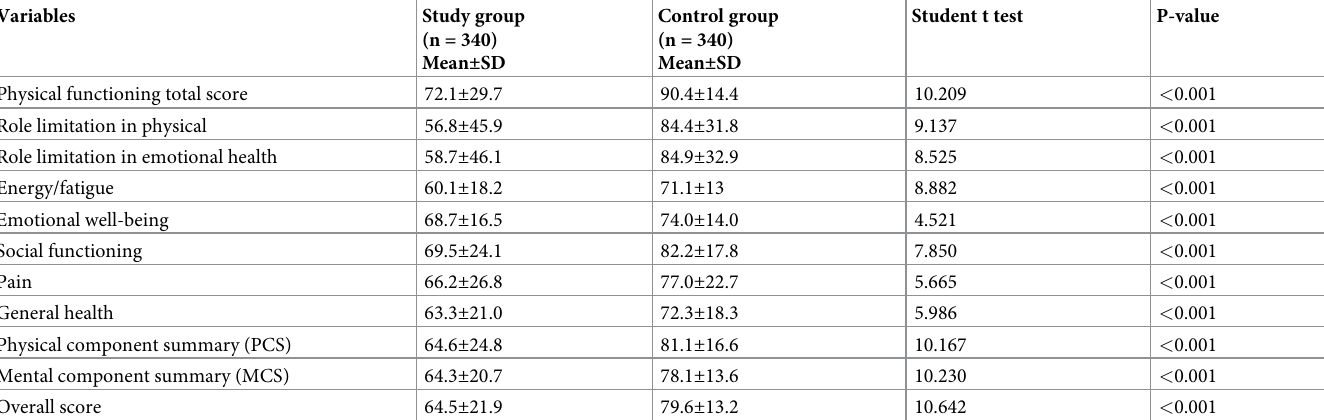
Table 2. Summary of HRQOL Measures in all the eight (8) sub-domains and composite scores among the respondents in study and control groups.